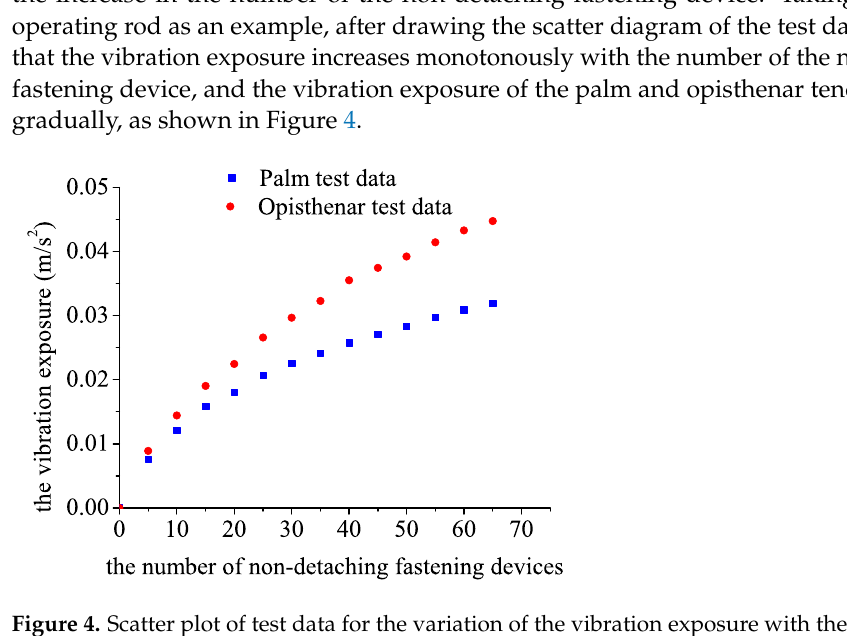
Figure 4. Scatter plot of test data for the variation of the vibration exposure with the number of the non-detaching fastening